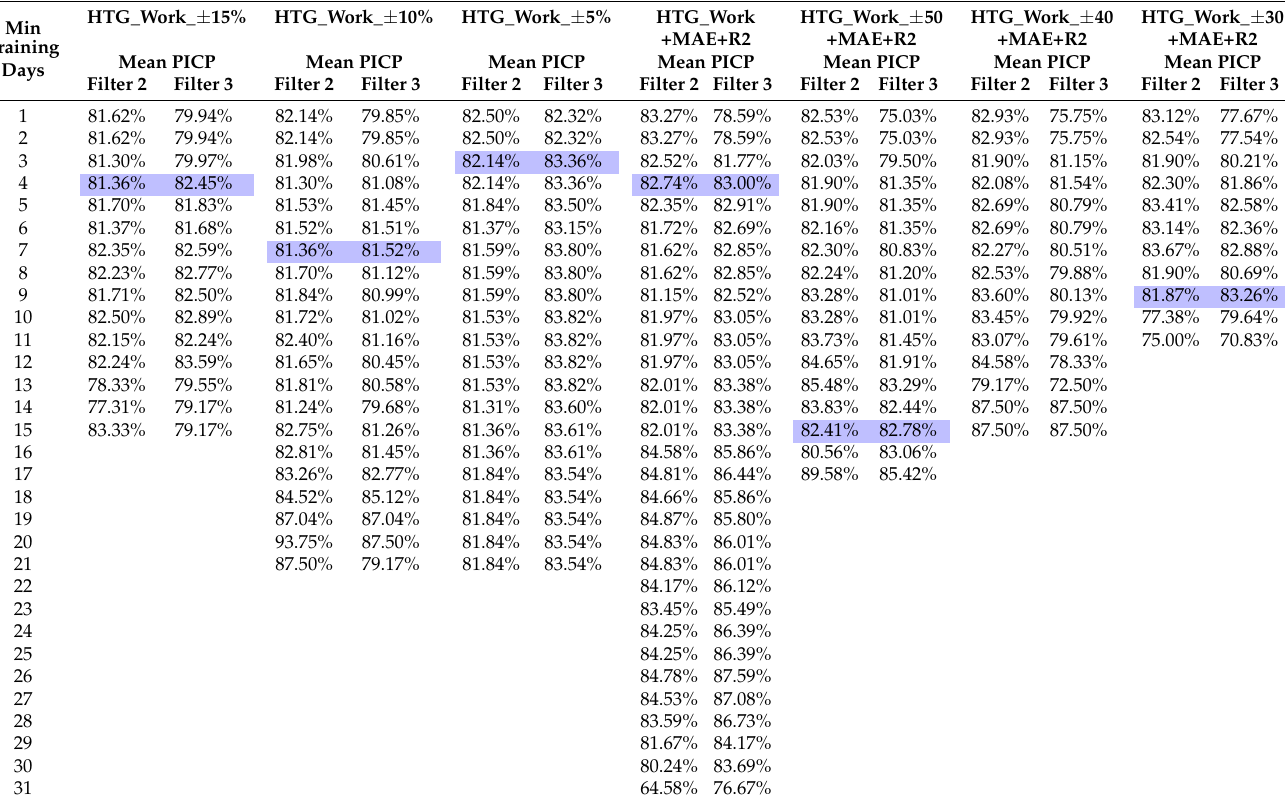
Table A2. Definition of the minimum number of training days required for each criterion within Filter 3. The highlighted cells show when the mean PICP of each criterion of Filter 3 improves the mean PICP of Filter 2.